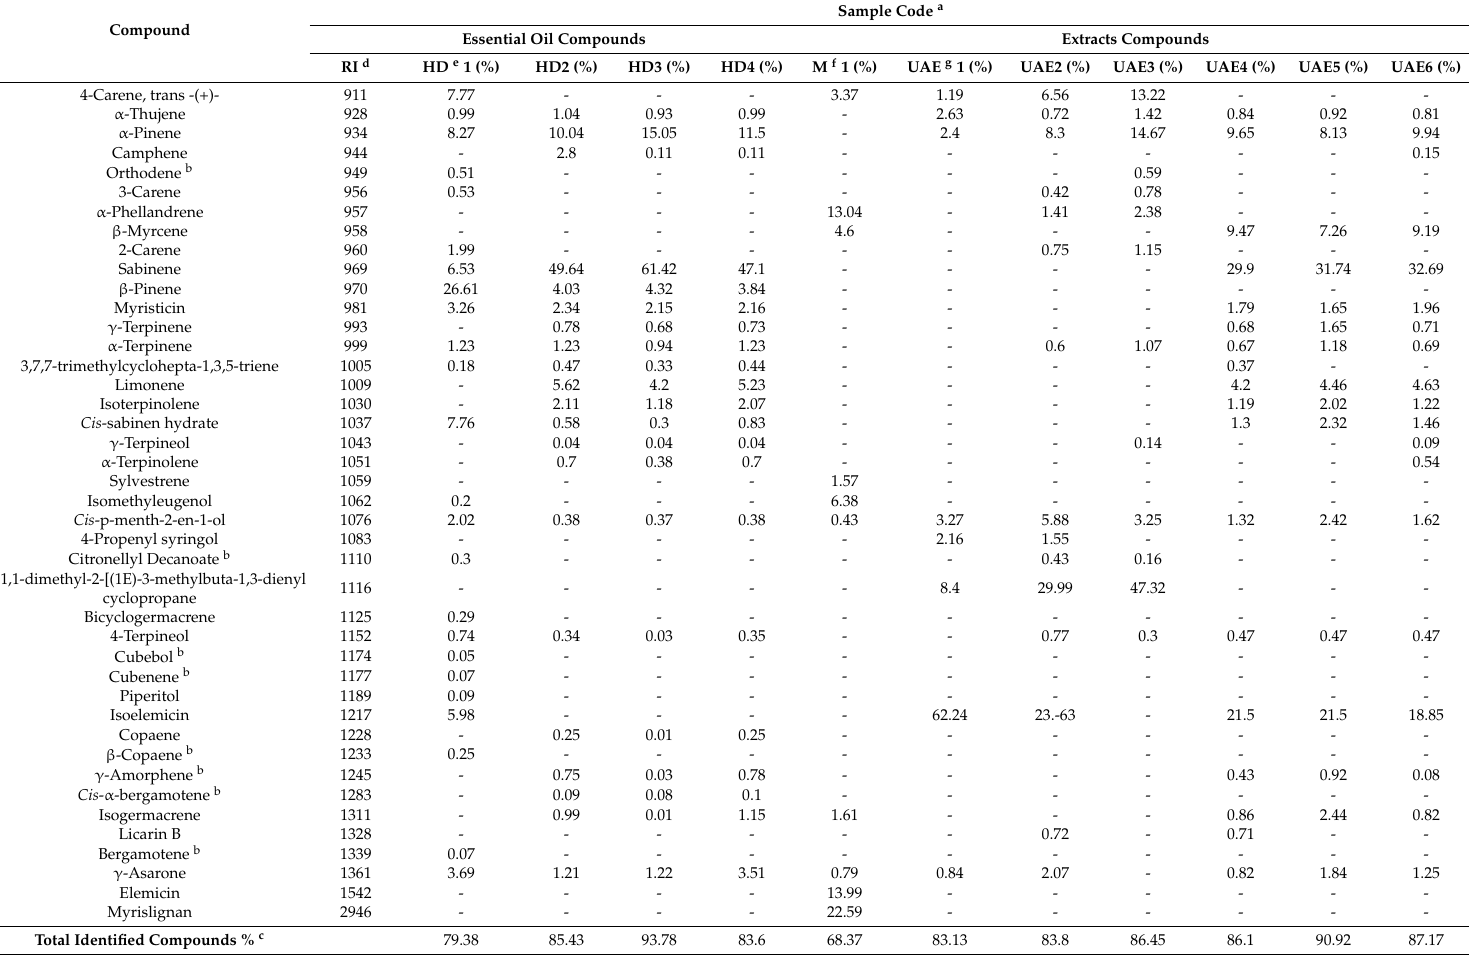
Table 2. Chemical composition of nutmeg extracts and essential